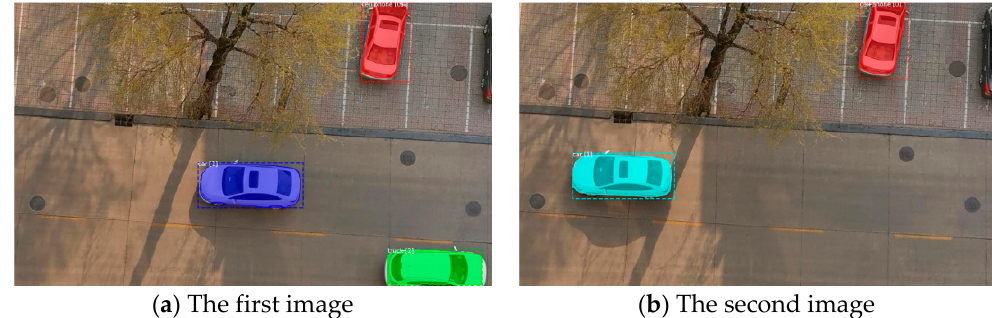
Figure 5. The results of Mask-R-CNN.